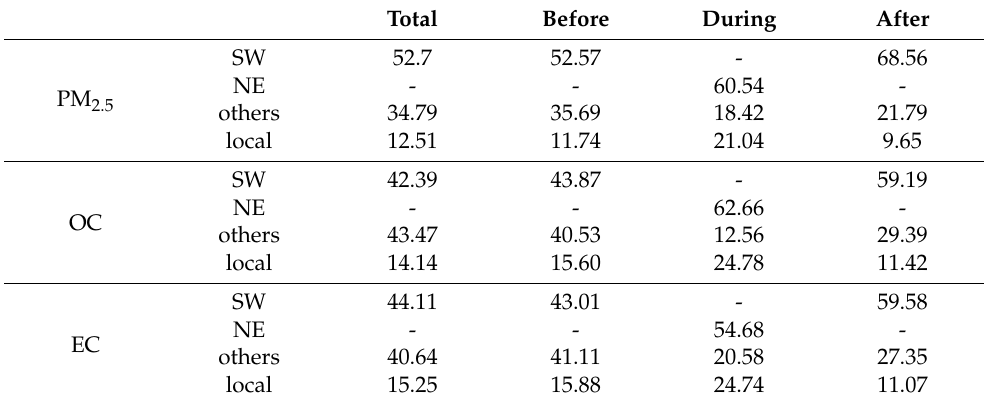
Table 4. Contribution percentage (%) of long-range transport paths. SW represents the southeast path. NE represents the northeast path. Others contains all not significant transport contribution. Local represents the transport within Beijing domain. The total column represents the whole sampling period. Only significant transport paths in CFA fields were calculated. Total Before During After SW 52.7 PM 2.5